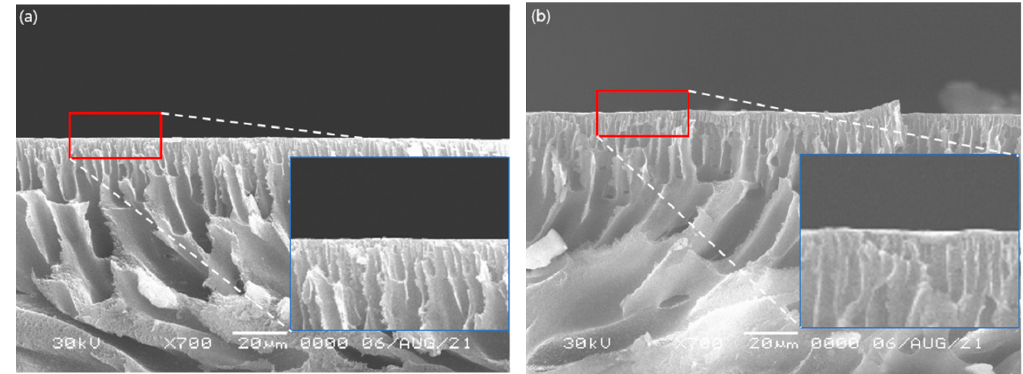
Figure 10. SEM images of the cross ‐ section of ( a ) PSf and ( b ) PSf+PEG substrate.